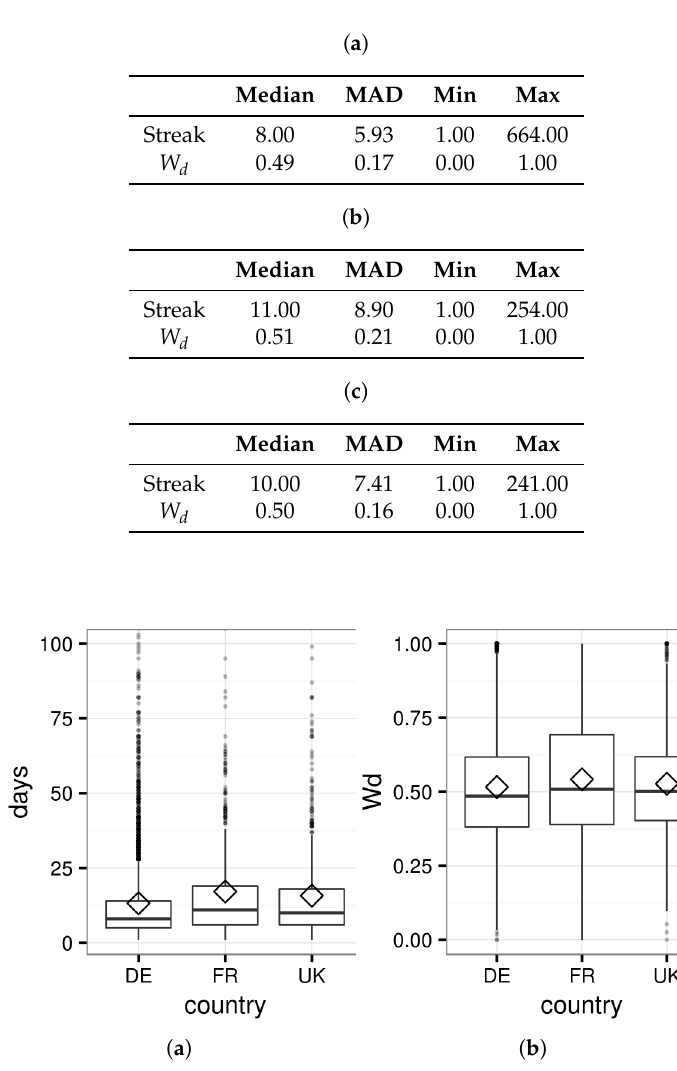
Table 5. Motivation Indicators. ( a ) Germany; ( b ) France; ( c ) the United Kingdom.